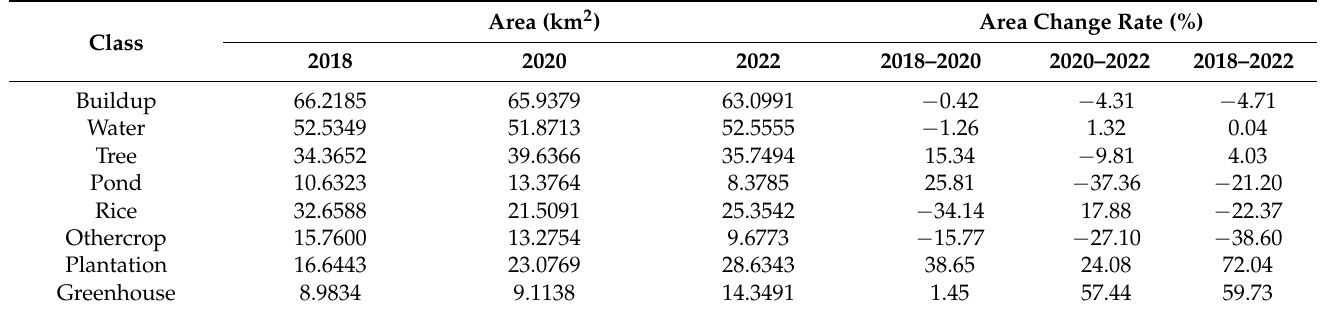
Table 13. Table of land use type changes in the study area for different periods from 2018 to 2022. Area (km 2 ) Area Change Rate Class